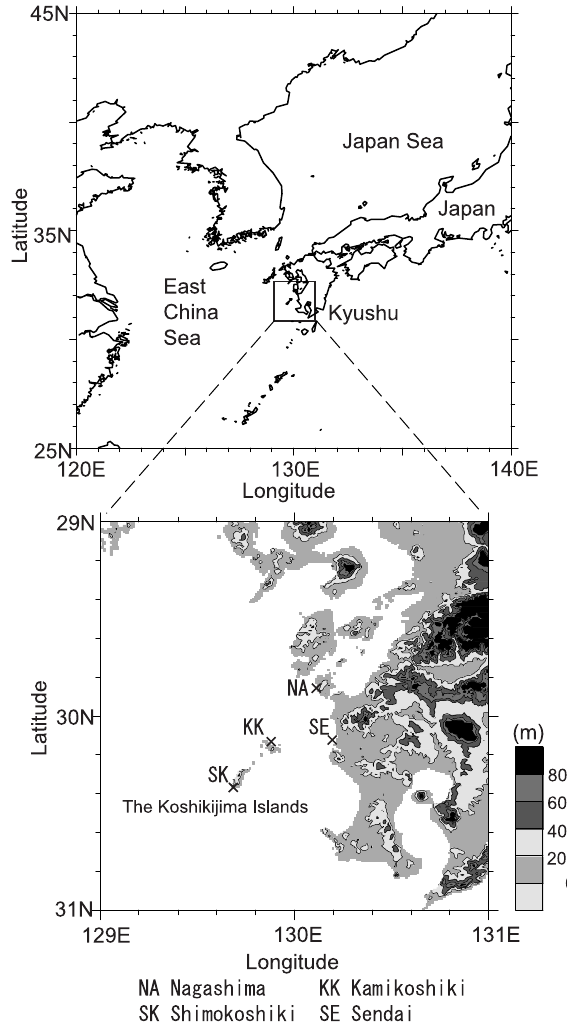
Fig. 1. Topographic map of observation